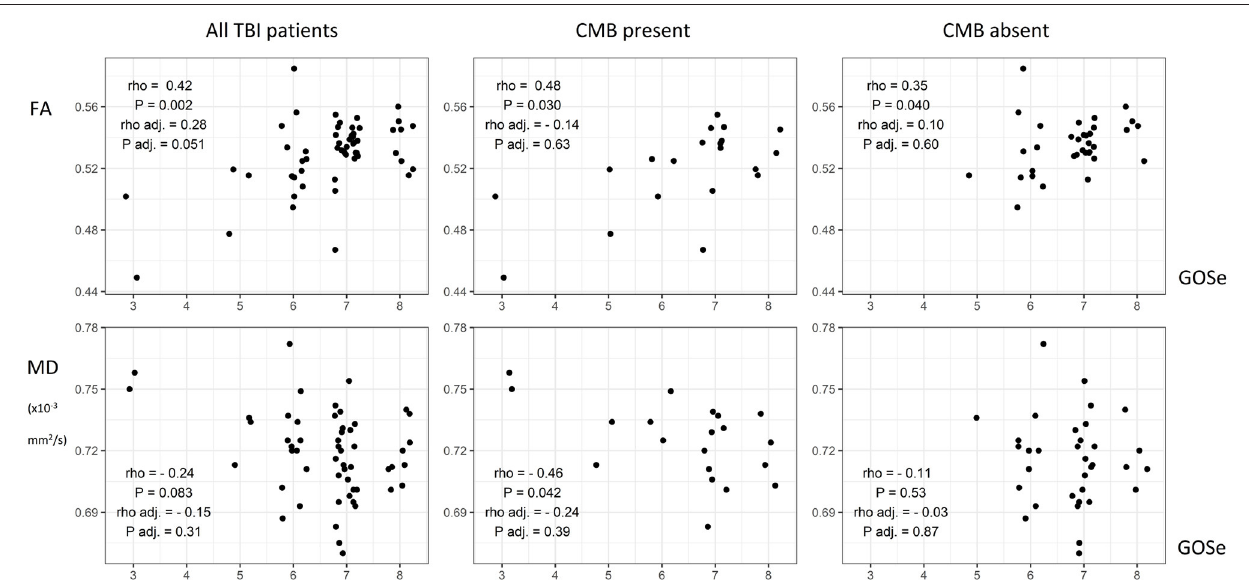
FIGURE 5 | Scatterplots of white matter microstructural properties and outcome including corresponding Spearman’s correlation coefficients with P -values. Additional coefficients and P -values for partial Spearman’s correlations adjusted for relevant background factors (age, sex, education level, time from injury to DTI) and clinical severity (Glasgow Coma Scale and length of post-traumatic amnesia) are shown. TBI, traumatic brain injury; CMB, cerebral microbleed; FA, fractional anisotropy; MD, mean diffusivity; GOSe, Glasgow Outcome Scale extended.